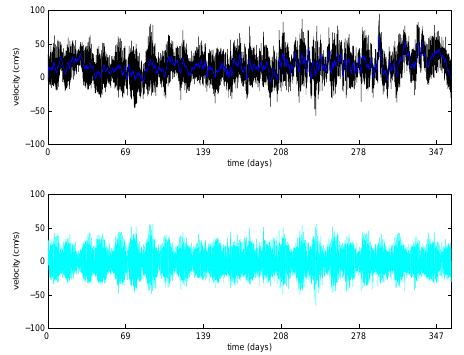
Fig. 2. Linearly interpolated raw data (black), low-passed data (blue) and high frequency data (cyan) are shown for u component at location NA, 170m